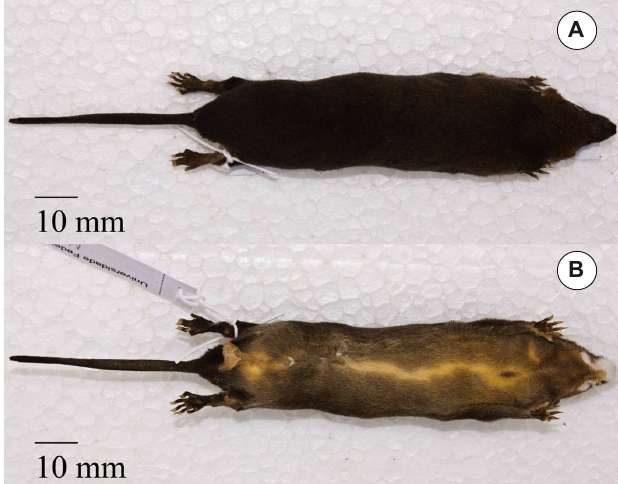
Monodelphis kunsi and their respective ecoregions according to Olson